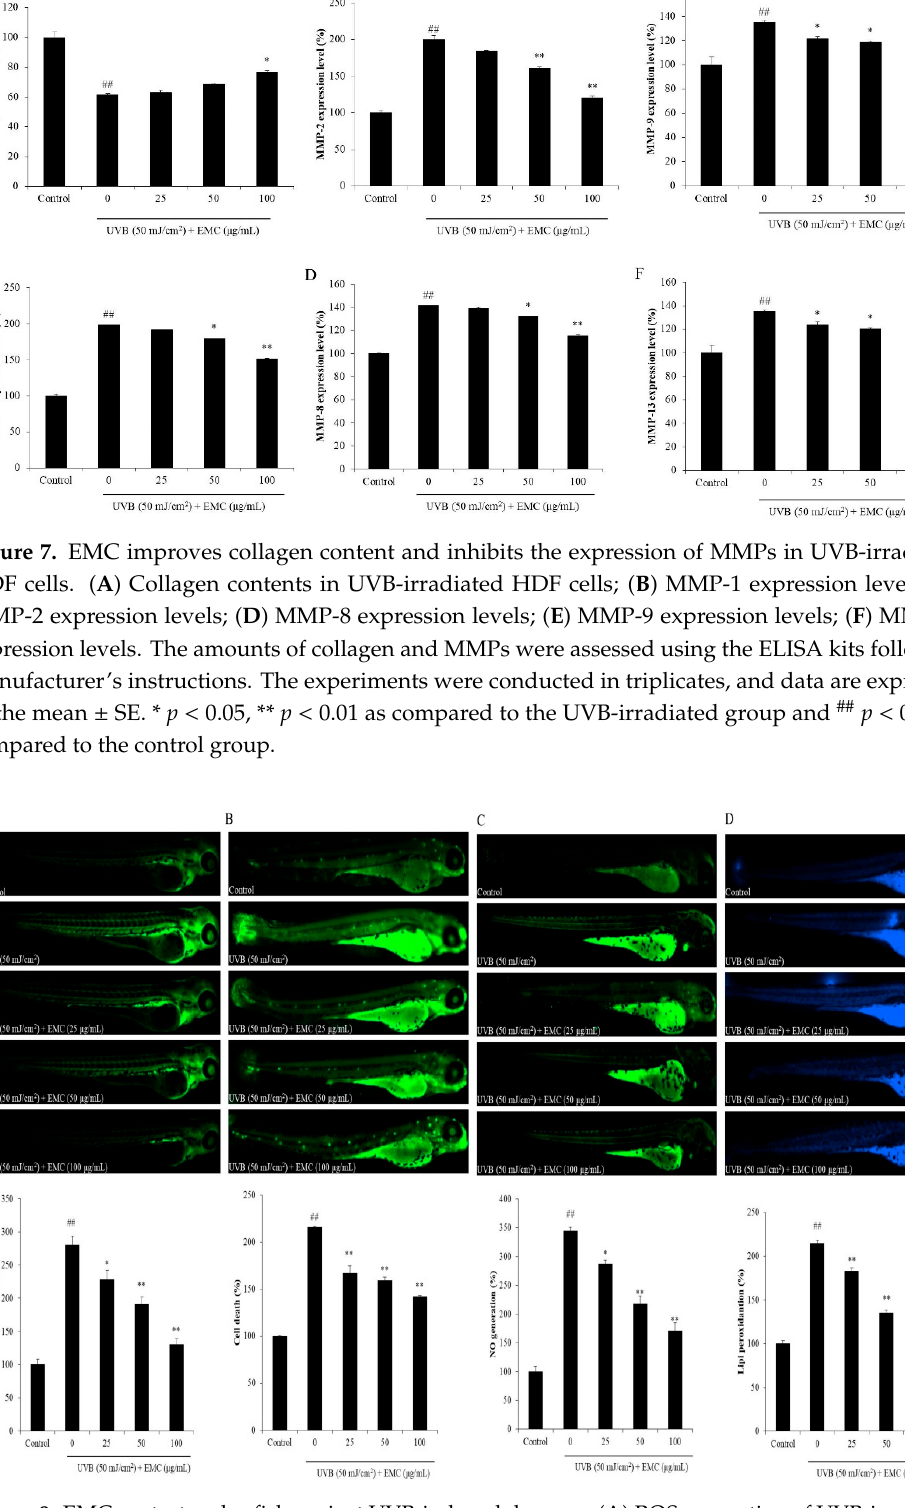
Figure 8. EMC protects zebrafish against UVB-induced damage. ( A ) ROS generation of UVB-irradiated zebrafish; ( B ) cell death; ( C ) NO production; and ( D ) lipid peroxidation. The relative